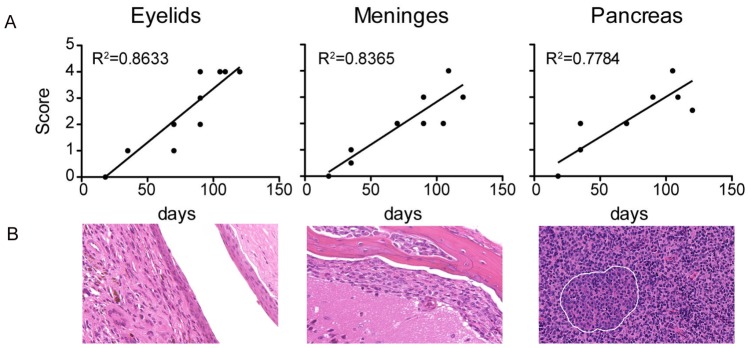
Severity of histiocytic inflammation increases with age.Histologic lesions were scored 0–4 and correlation was tested in BAC#2+/MyD88WT mice up to 120 d. Thirteen mice are analyzed. A. In eyelids, meninges and pancreas, histiocytic infiltrates increases in severity with age. B. Hematoxylin and eosin-stained representative examples of severe inflammation in tissues as indicated (20x). White line demarcates a pancreatic islet.